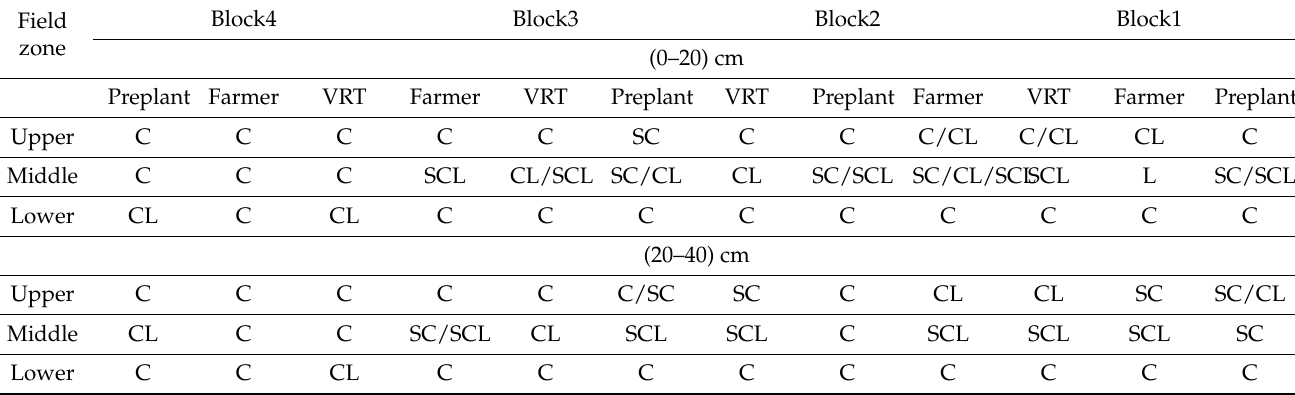
Table 3. Soil texture analysis of the experimental plots (0–20 cm and 20–40 cm) (*).